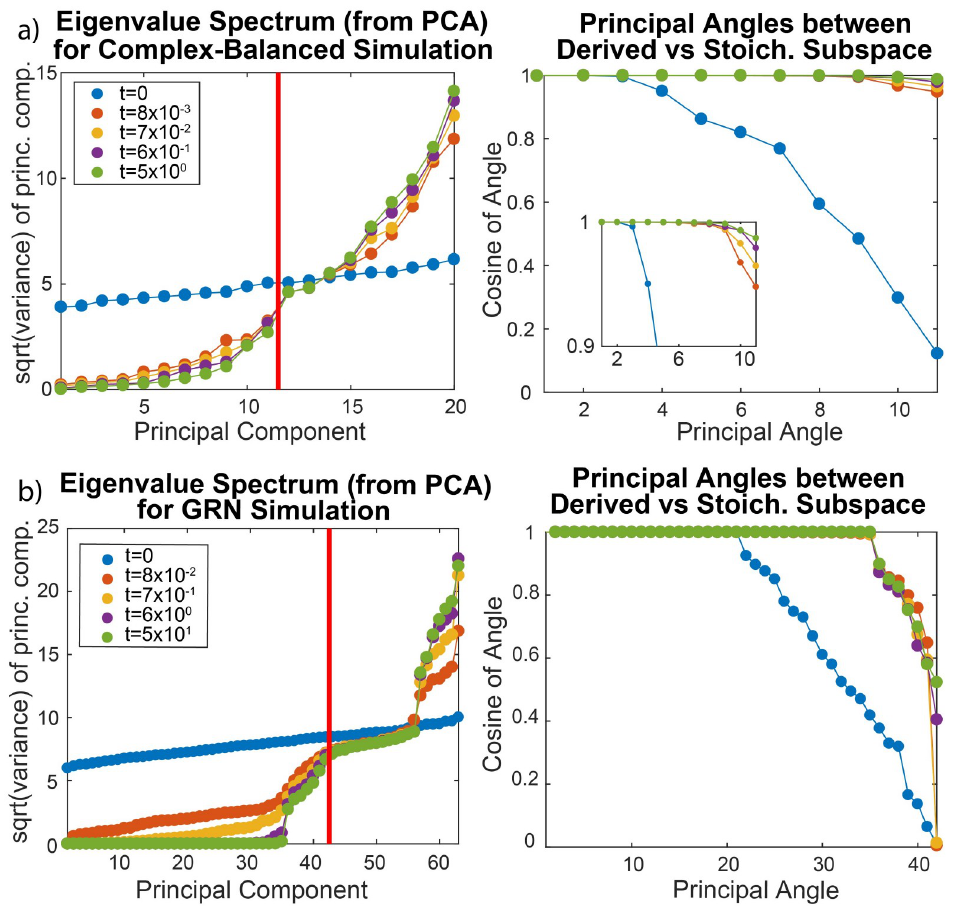
Fig 3. Reaction network simulations and deriving stoichiometric subspaces. (a) Example complex-balanced simulation, analyzed by PCA, shows 11 small eigenvalues, as expected from the simulated network’s structure, leading to a gap (red line) that grows larger with time. PAD shows that the span of these 11 eigenvectors converges to the true stoichiometric subspace. The 10th and 11th eigenvalues decrease slower than the others, due to slow reactions in the simulation. (b) An example GRN simulation for n = 7 is shown. From PCA, a gap in eigenvalues occurs at the expected dimension of the stoichiometric subspace (red line), as well as after the 35th eigenvalue. From PAD, the first 35 eigenvectors span the same subspace as the reversible binding reactions. The remaining 7 eigenvectors before the gap, whose eigenvalues are not as small, span a log-linear space tilted away from the stoichiometric subspace by angles between π /6 � π /3. Simulation parameters and networks for both examples are provided in S1